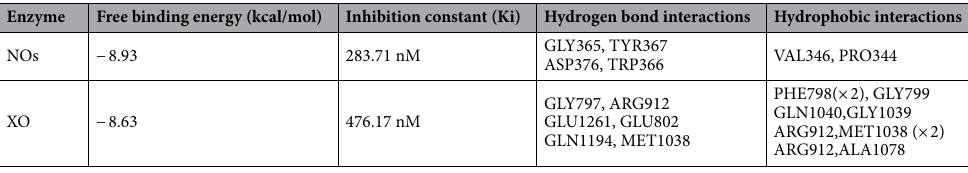
Table 6. Interaction constants of AFM 2 with NOs and XO enzymes.